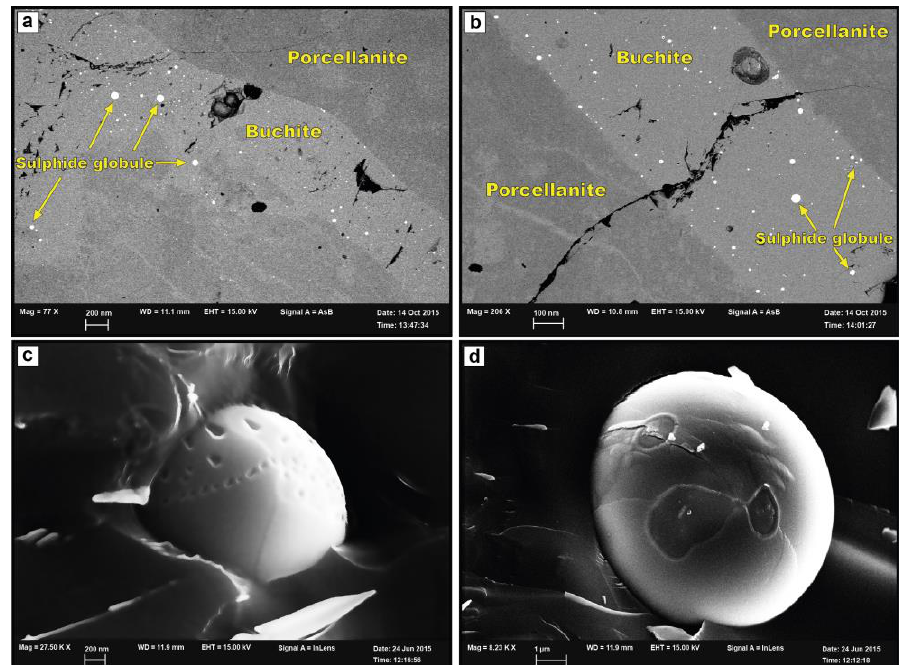
Figure 6. FESEM backscattered image of the composite B1 xenolith at lower ( a ) and higher ( b ) magnification, showing intimately mingled porcellanite and buchite. The two portions of the pyrometamorphic xenolith are also distinguished by the presence of sulphide globules only in the buchite portions as further emphasized in the X-ray µ CT imaging provided in Figure 8a and Video S1. Sharpened FESEM images of sulphide globules exposed on the surface of a buchite glass shard from sample B1, having a size of about 2 µ m and 8 µ m are shown in ( c ) and ( d ),